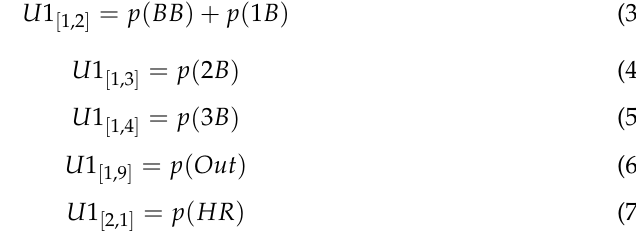
Table 1. The twenty-five codes for outs and base